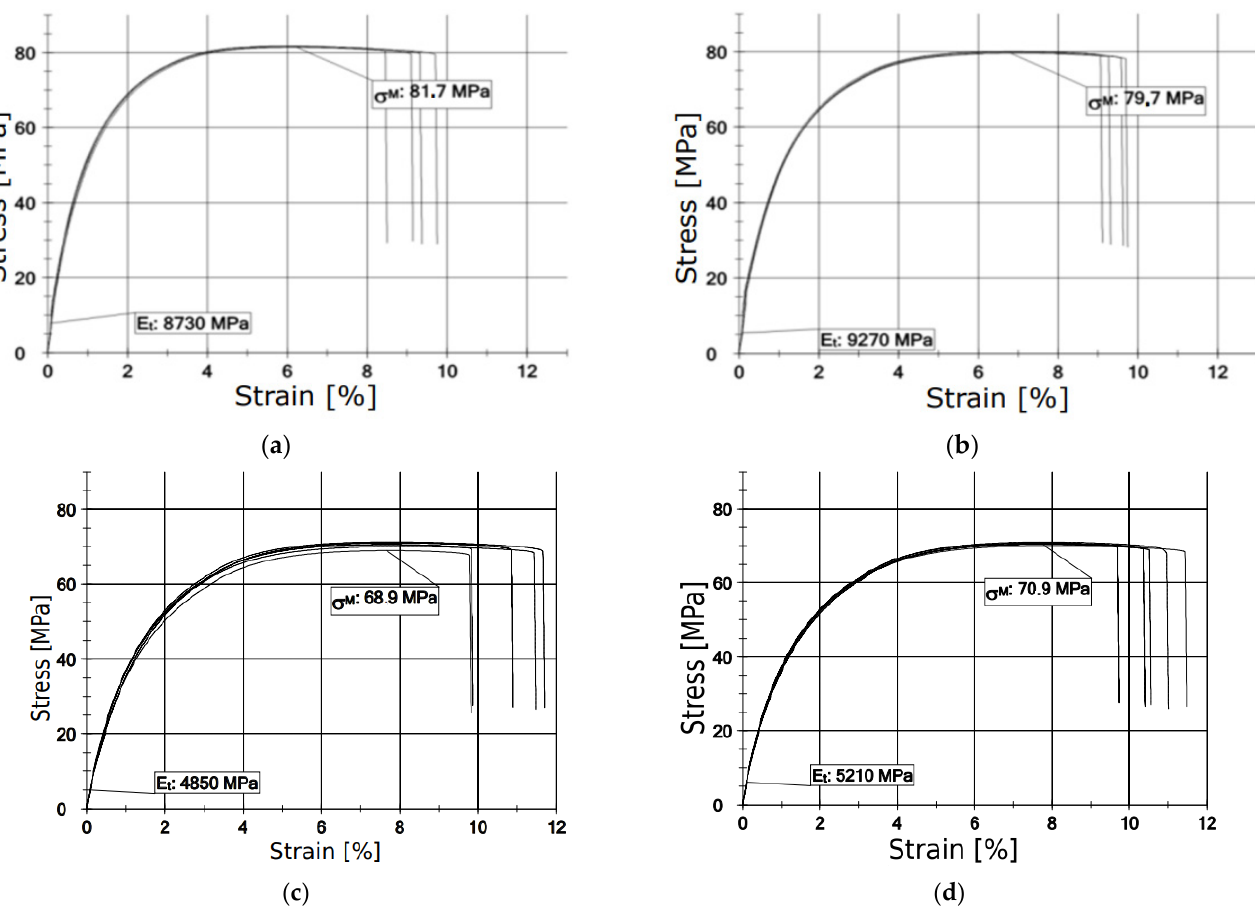
Figure 8. Selected characteristics σ − ε obtained in a tensile strength test after the exposure to thermal shocks: ( a ) 20 ◦ C, ( b ) 160 ◦ C—1 min, ( c ) 5 cycles × 100 ◦ C—25 min, ( d ) 5 cycles × 160 ◦ C—1 Table 3. Descriptive statistics of results of Ultramid tensile test after being treated with the hot air- flow.